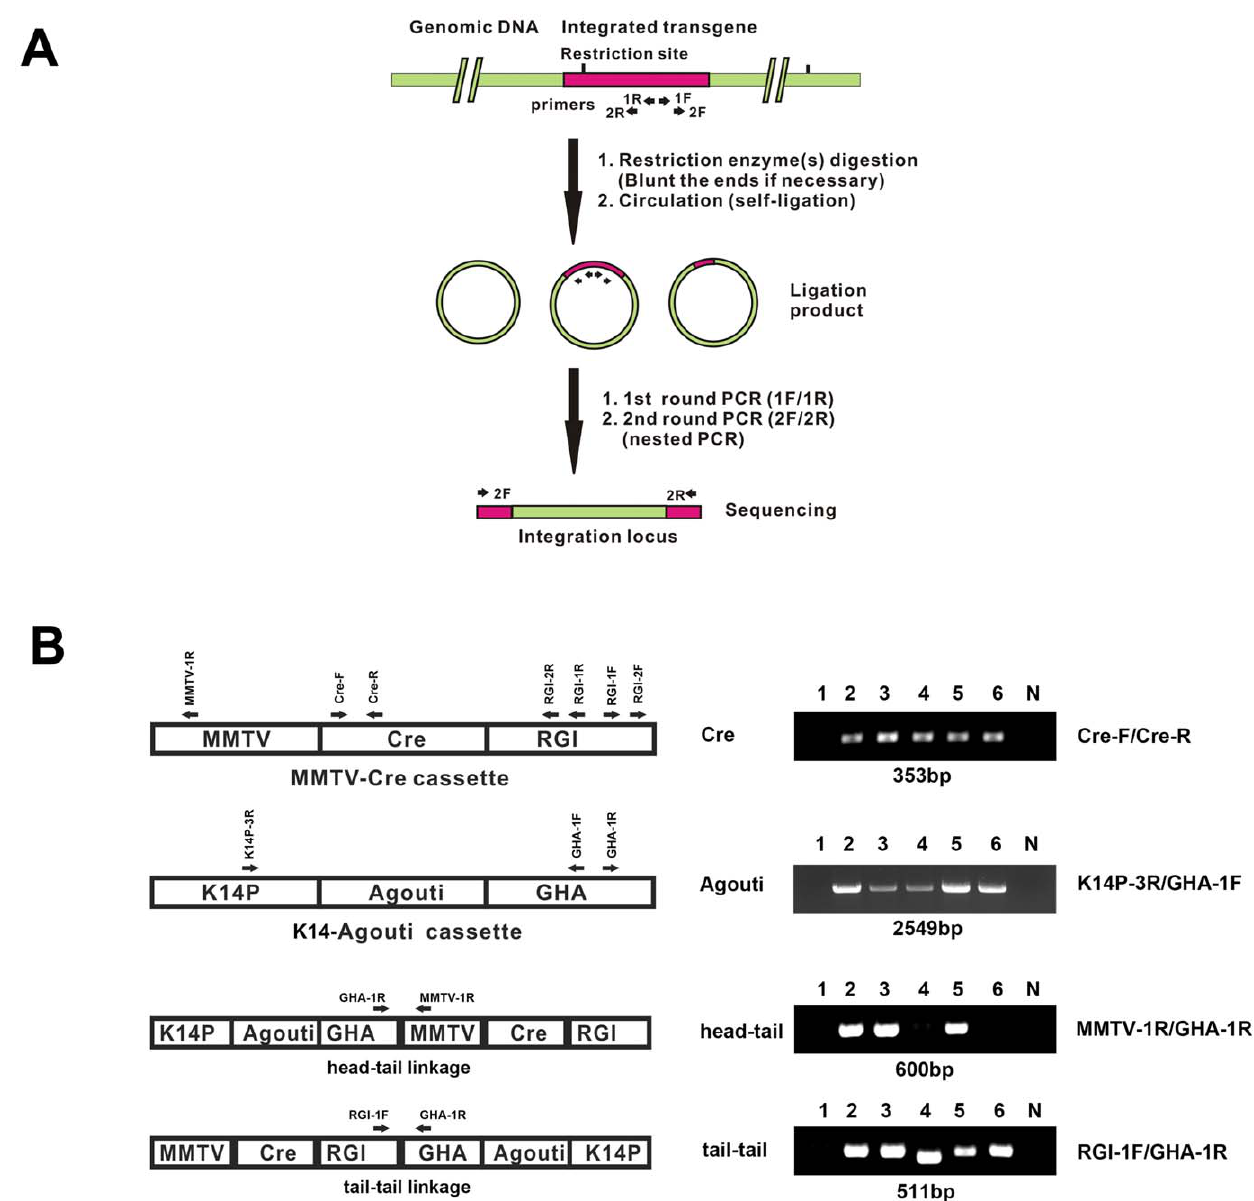
Figure 4. Identification of the linkage of the K14-Agouti cassette to the MMTV-Cre transgene using inverse PCR. (A) The schematic diagram of the inverse PCR. (B) PCR using specific primer sets identified the K14-agouti cassette adjacent to the MMTV-Cre transgene. The linkage of the linkage of the MMTV-Cre and K14-agouti transgenes allow distinction of the line A, line D and line F founder lines. The MMTV-Cre cassette [5] also contains a rabbit growth hormone intron sequence (RGI). The K14-Agouti cassette [14] also contains a human growth hormone polyadenylation sequence (GHA). The Cre-F/Cre-R primer set identifies the presence of Cre gene. The K14P-3R/GHA-1F primer set identifies the presence of the K14- agouti cassette. The MMTV-1R/GHA-1R primer set identifies the presence of the head-to-tail linkage of the K14-agouti cassette and the MMTV-Cre cassette. The RGI-1F/GHA-1R primer set identifies the presence of the tail-to-tail linkage of the MMTV-Cre cassette and the K14-agouti cassette. 1, wild type DNA; 2, MMTV-Cre DNA used in this study; 3, MMTV-Cre line A DNA from Jackson lab; 4, MMTV-Cre line D from Jackson lab; 5, MMTV-Cre line A DNA from Hennighausen lab; 6, MMTV-Cre line F DNA from Hennighausen lab; N, no DNA control. Note, lane 2, 3, and 5 (all Line A) have the same PCR fragments for the head-tail and the tail-tail linkages whereas lane 4 (line D), and lane 6 (line F) only have PCR fragments for the tail-tail linkage. The sizes of PCR products are listed under each DNA gel panel.